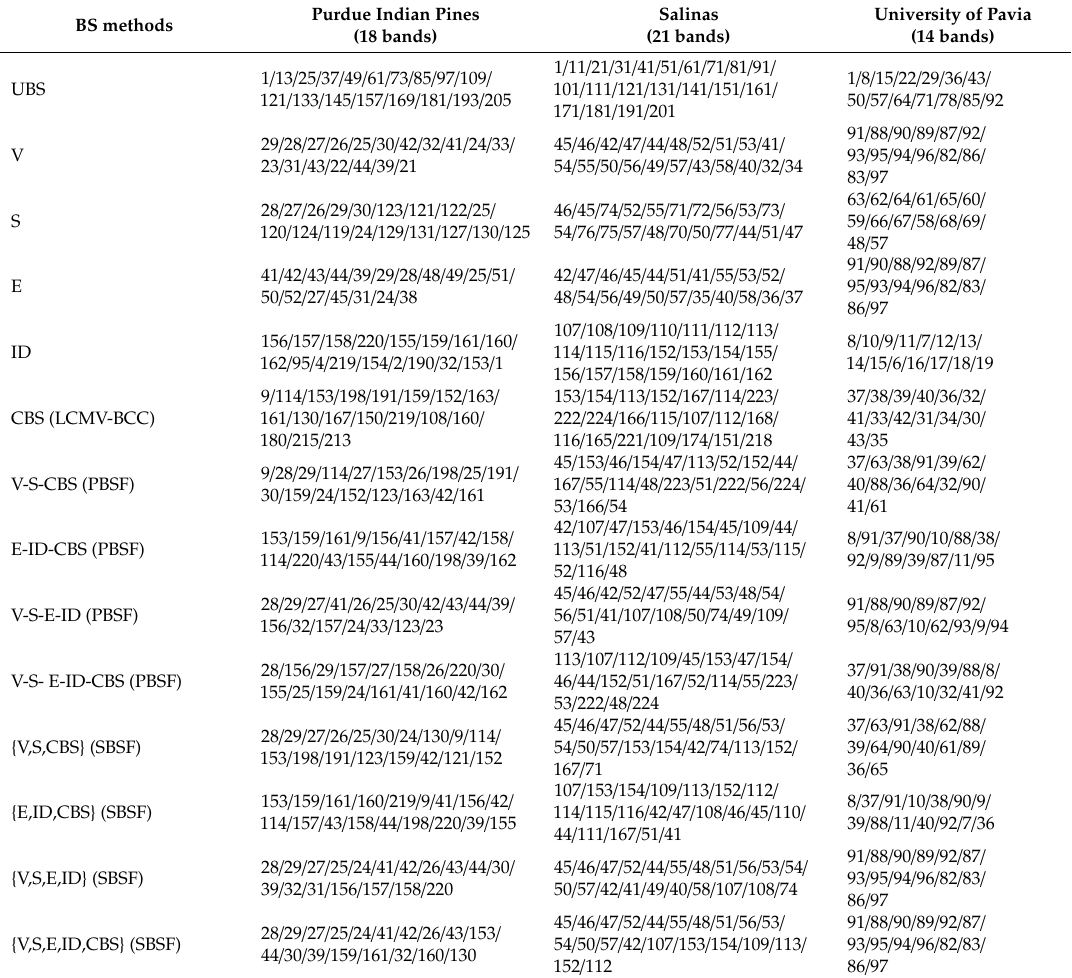
Table 7. Bands selected by various BS methods and SBSF and